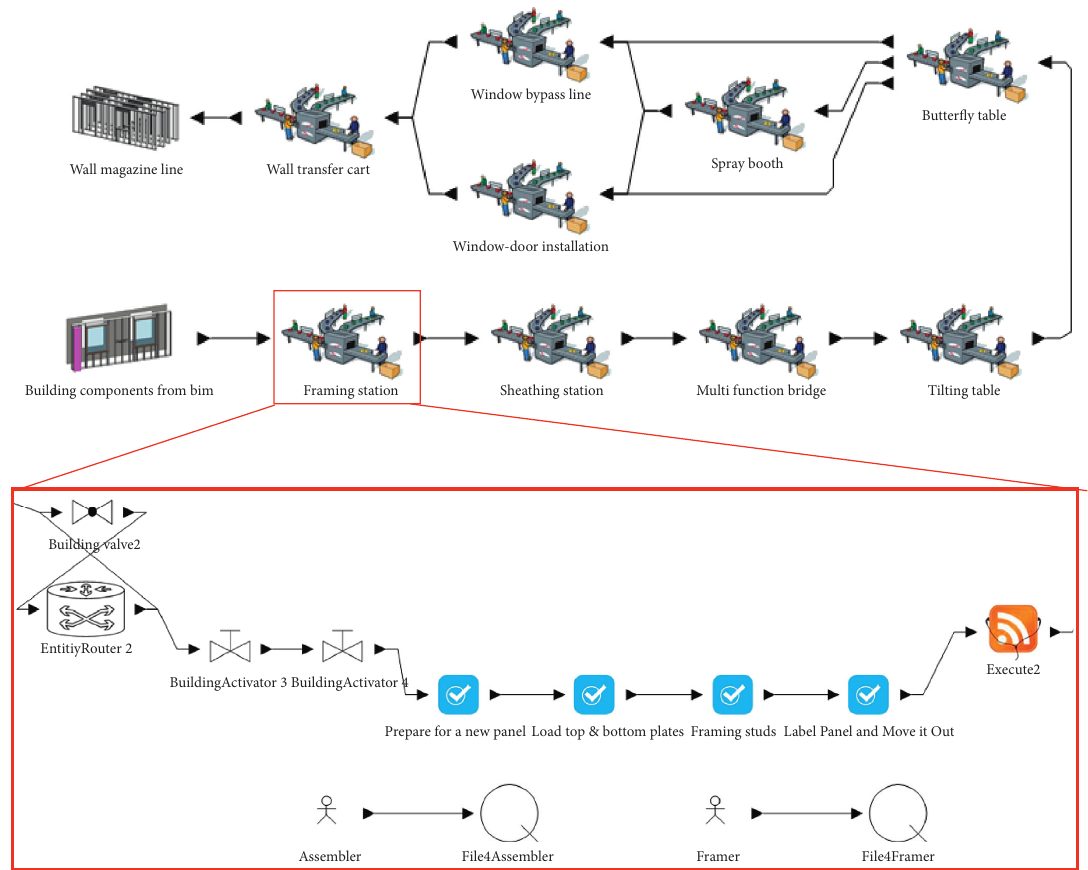
Figure 5: A simulation model of the wall production line.